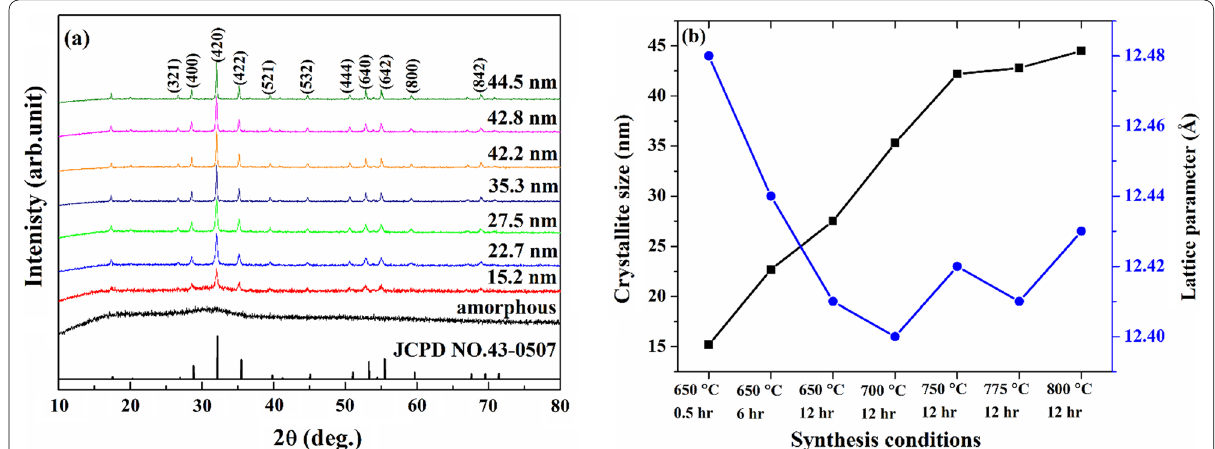
Fig. 1 a XRD patterns of the Bi‑doped YIG nanopowder synthesized at various conditions and, b variation of crystallite size and lattice parameter with the change of the synthesis